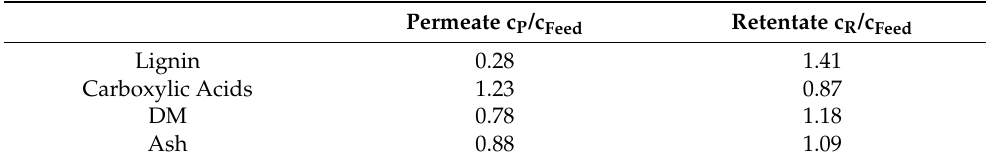
Table 2. Relative concentrations of the BL constituents in the permeate (c P ) and retentate (c R ) stream of a typical NF experiment. Data for NF treatment of pretreated BL to a volume reduction of